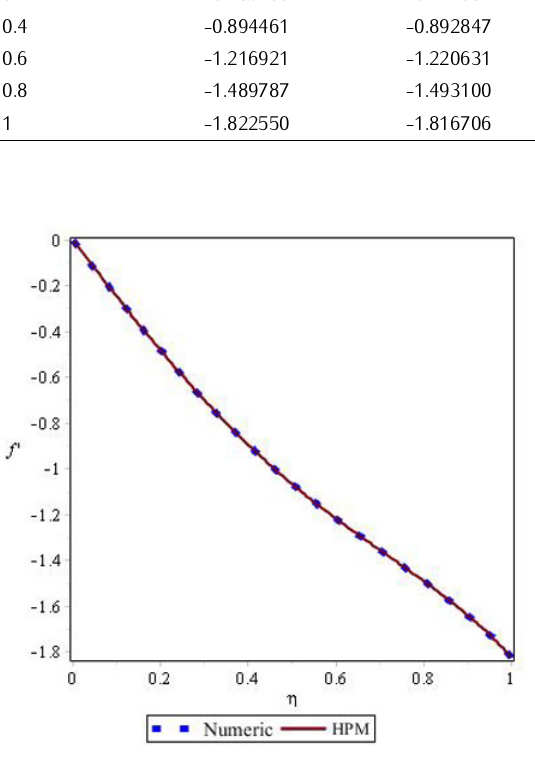
Figure 5. A comparison between the achieved solutions for f 0 ( η ) by AGM and numerical